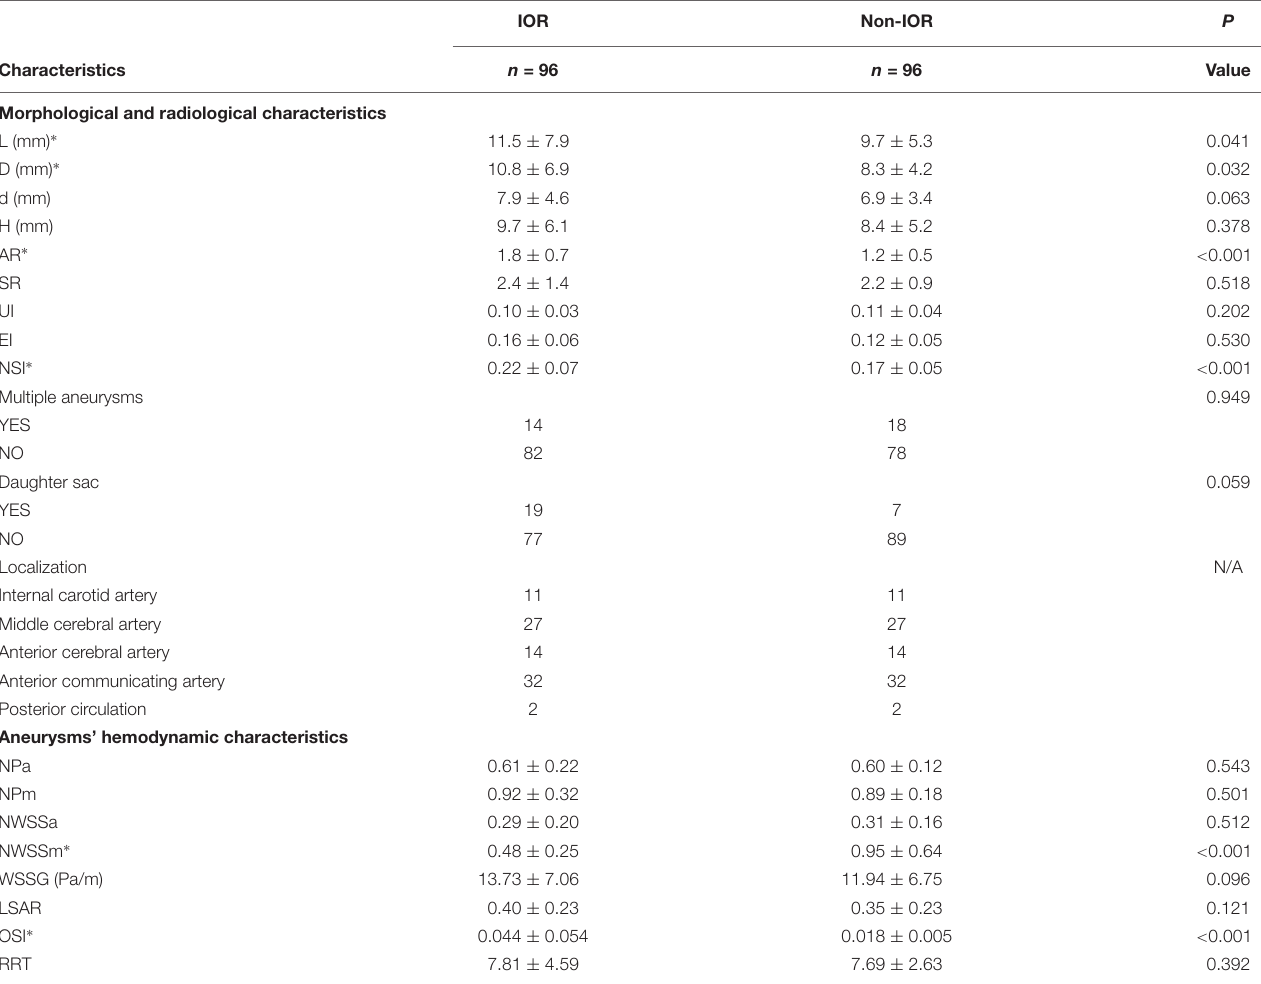
TABLE 2 | Morphological and radiological characteristics, aneurysms’ hemodynamic characteristics.